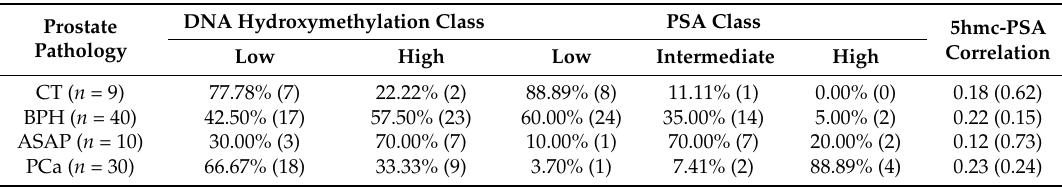
Table 2. Distribution of DNA hydroxymethylation and PSA classes and association between these variables among patients with different prostate pathologies.